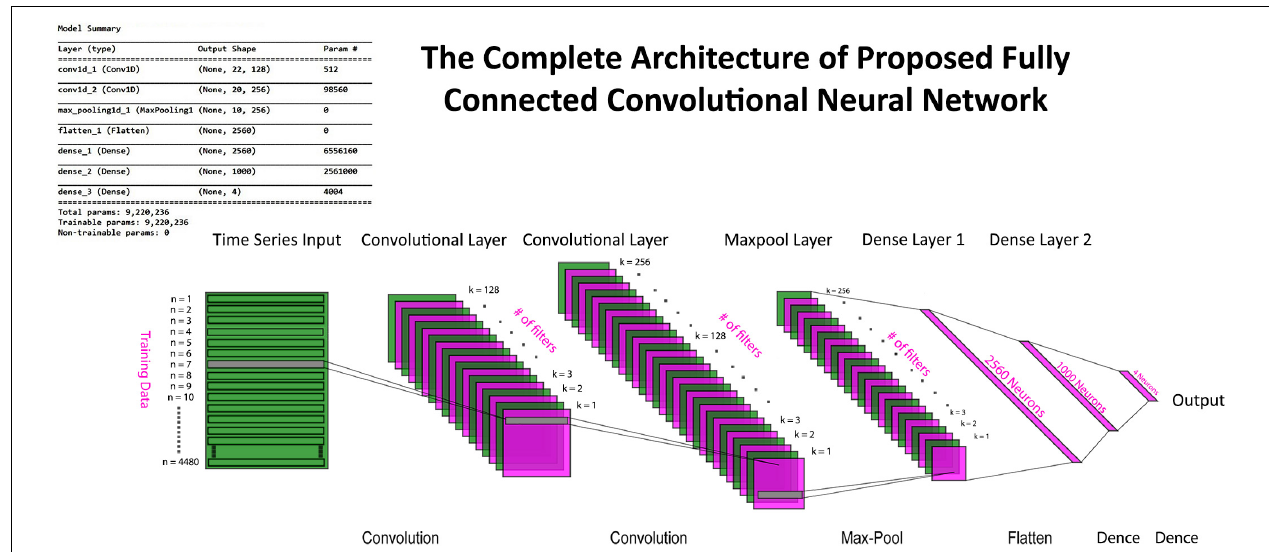
FIGURE 7 | The complete convolutional neural network (CNN) model with input, convolution, max pool, dense, and output layers. Model summary include details about hyperparameters and network architecture.